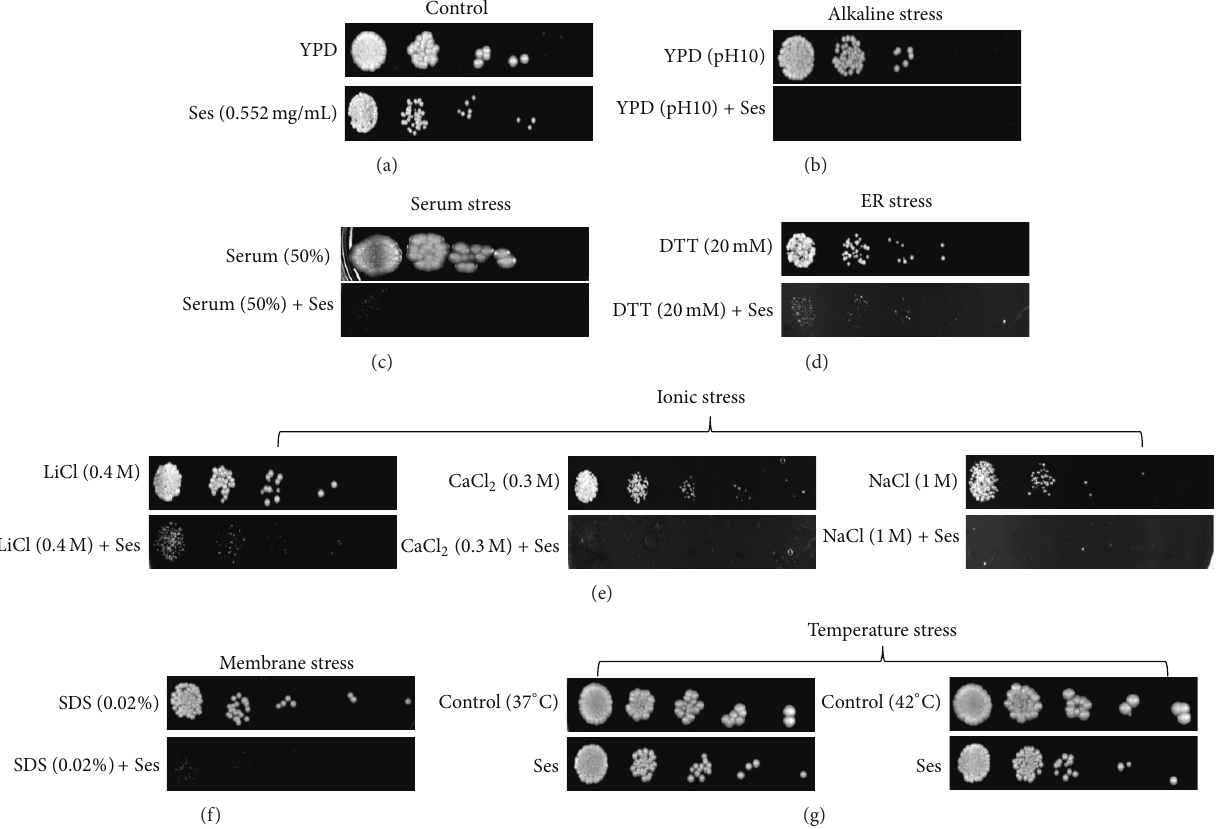
Figure 5: Phenotypic susceptibility assays to reveal the effect of Ses on the calcineurin dependent phenotypes in C. albicans . (a) Spot assay with and without Ses (0.552 mg/mL) as controls. (b) Spot assay with Ses at elevated pH 10 showing hypersensitivity to C. albicans . (c) Spot assay depicting the loss of growth in cells treated with serum (50% w/v) along with Ses. (d) Spot assay showing loss of growth under ER stress by DTT (20 mM) in presence of Ses. (e) Spot assays showing sensitivity in the presence of Ses under various ionic stress conditions with LiCl (0.4M), CaCl 2 (0.3M), and NaCl (1M). (f) Spot assay demonstrating the attenuated growth of C. albicans in the presence of Ses with membrane perturbing agent SDS (0.02% w/v). (g) Spot assay demonstrating no growth loss at elevated temperature at 37 ∘ C and 42 ∘ C in the presence of